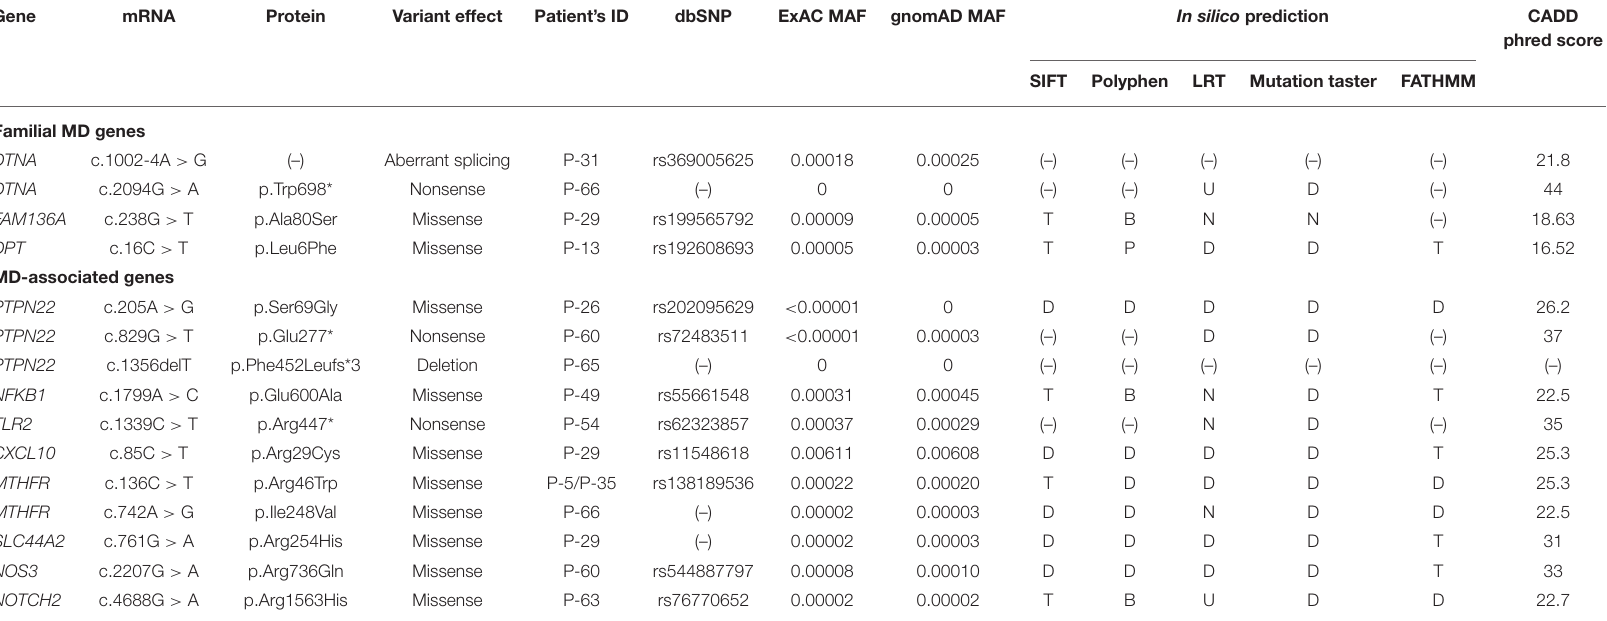
TABLE 1 | Identified rare variants in putative candidate genes associated with Meniere’s